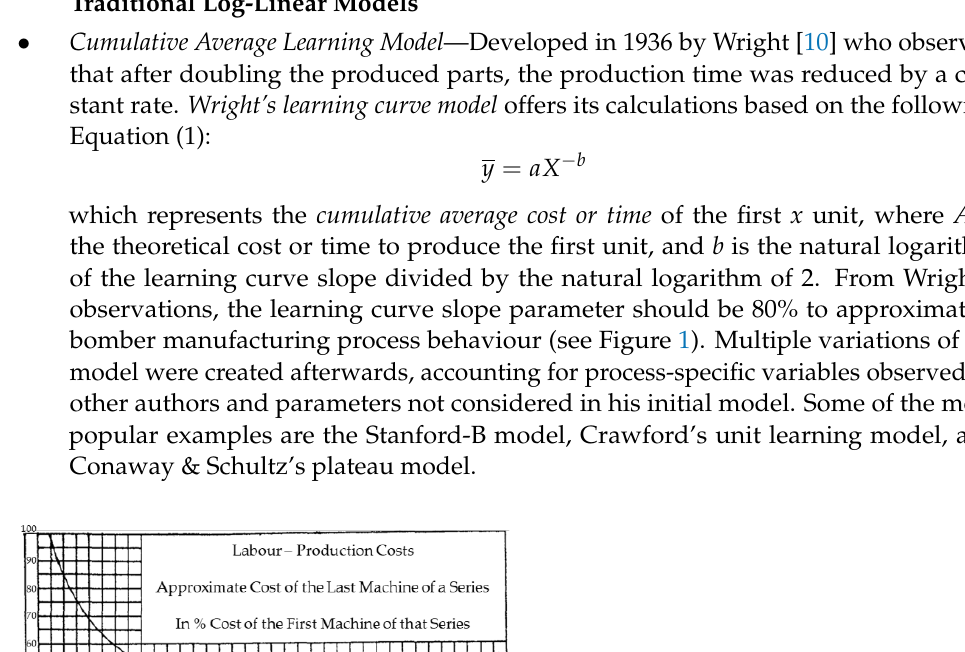
Figure 2. Unit l earning model graphic [12]. These previous log-linear models as presented by Wright [10] and Crawford [12] had a main disadvantage in the long term; the learning rate would keep on reducing the esti- mated cycle time indefinitely, which prompted several other authors to explore and de- velop better fitting models to account for the reduced learning rate. Adapted Log-Linear Models •